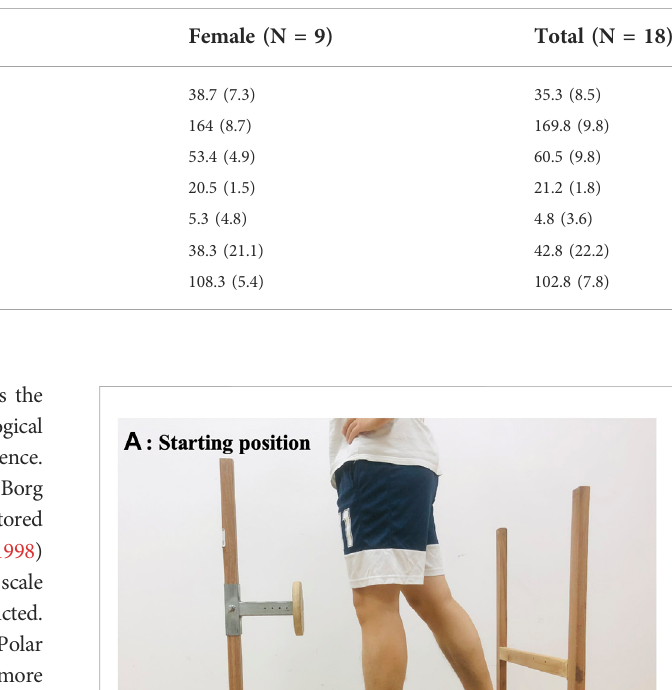
TABLE 1 Participant demographics: Mean (standard deviation).